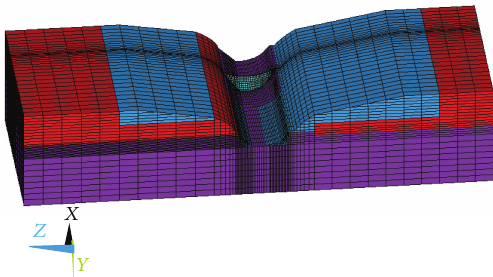
Figure 13: Generalized three-dimensional finite element model of the slope and arch dam.